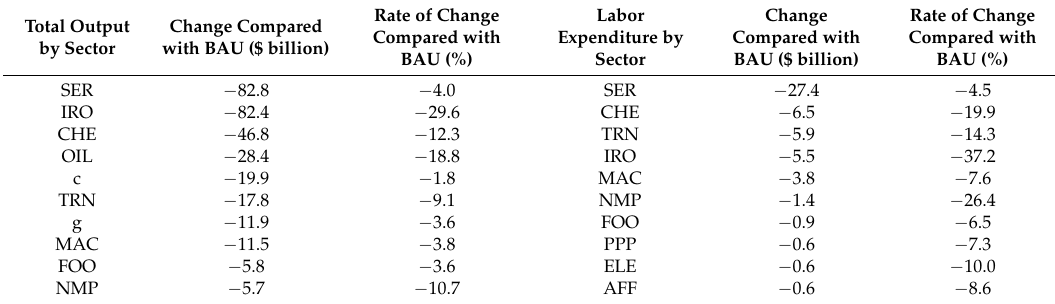
Table 12. GHG_30 Scenario ripple effects by